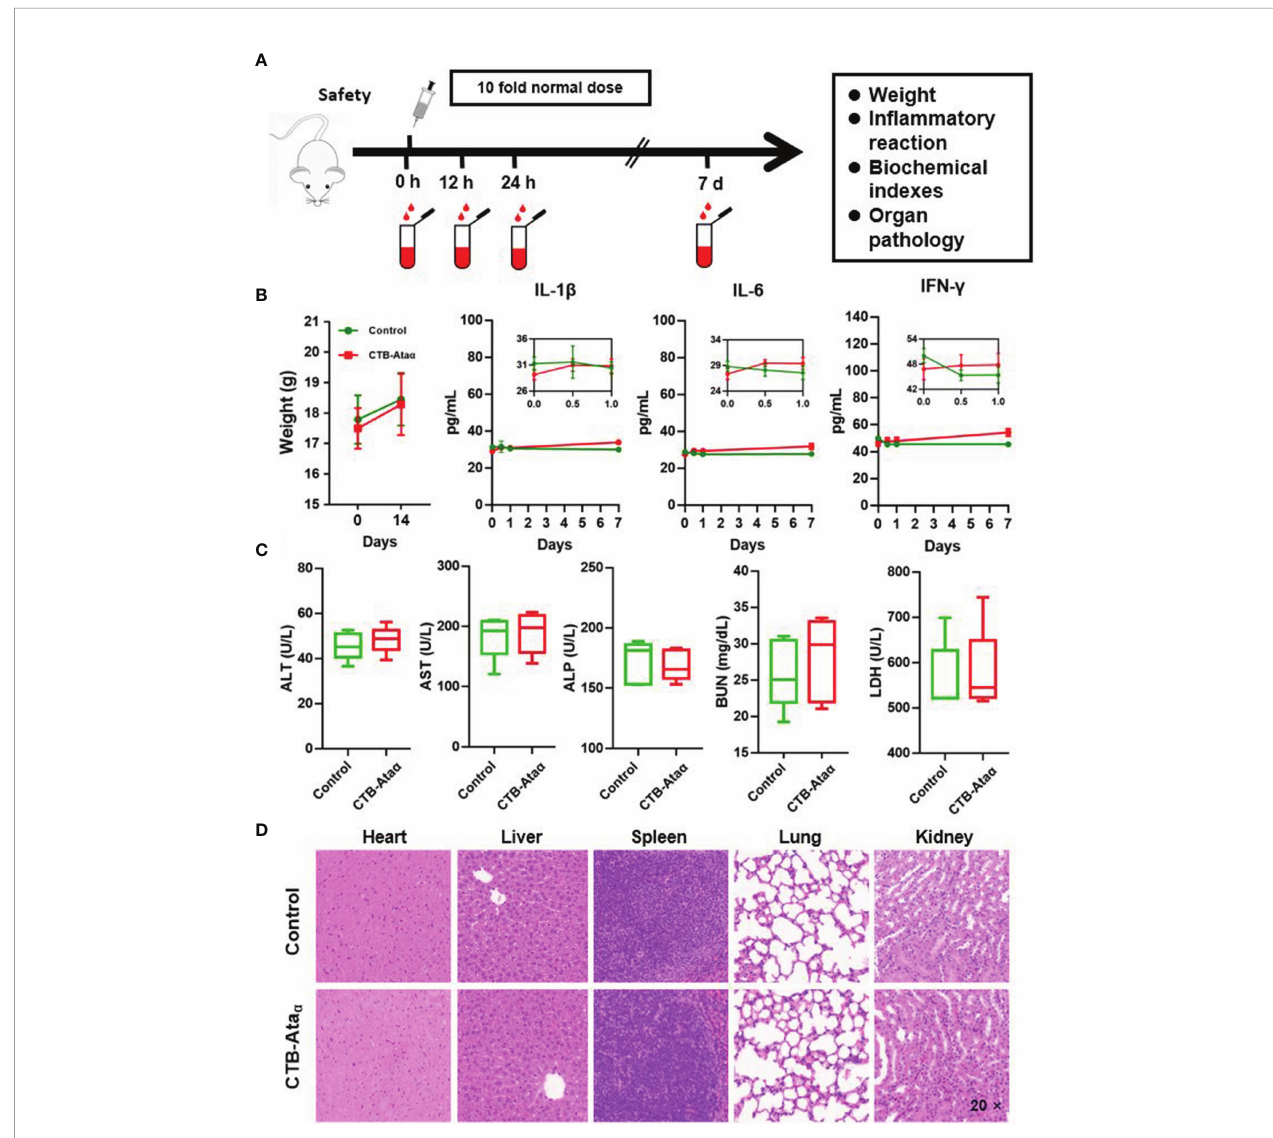
FIGURE 2 | Safety evaluation of CTB-Ata a . (A) Schematic procedure of the safety estimation. (B) Body weight and in fl ammatory cytokine levels (IL-6, IL-1 b , and IFN- g ) in serum at different time points after immunization with 10 times the normal dose. Data are presented as means ± s.d. (C) Detection of serum biochemical indices, including ALT, ALP, AST, BUN, and LDH, 14 days after immunization. Data are presented as means ± range. (D) HE staining analysis of mouse organs (including heart, liver, spleen, lungs, and kidney) 14 days after